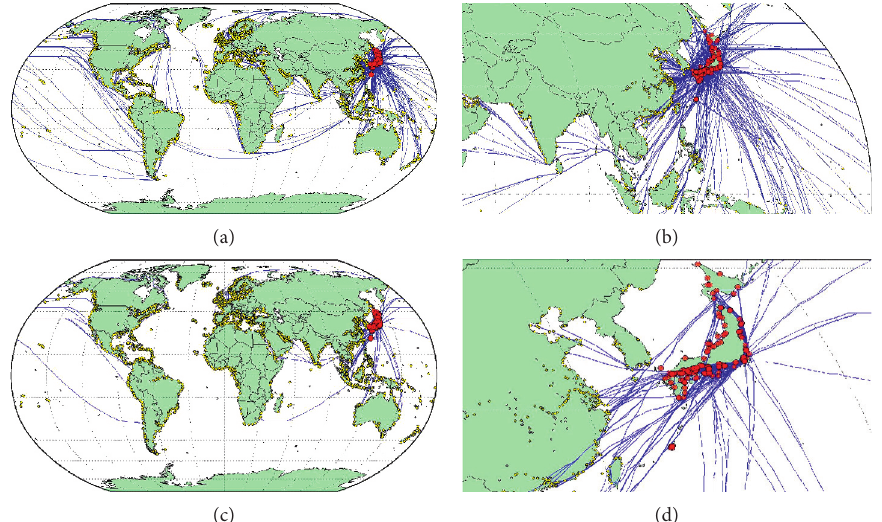
Figure 6: Multijump connections from Japanese ports. (a) Global view (all). (b) Regional view (all). (c) Global view (Top 2000). (d) Regional view (Top 2000).